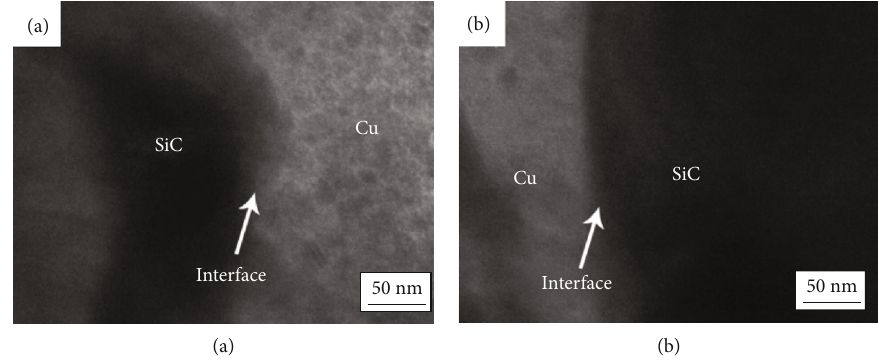
Figure 8: TEM photo of SiC@Cu/Cu composites: (a) 10% SiC@Cu and (b) 30% SiC@Cu.